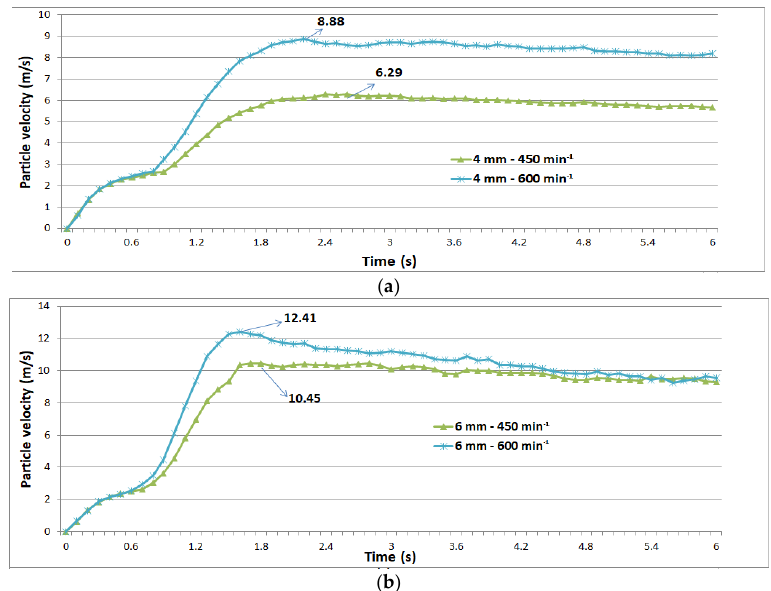
Figure 7. Average velocity of the particles of fertilizer I ( a ) and fertilizer II ( b ) when the discharge flow rate was 200 g s − 1 .